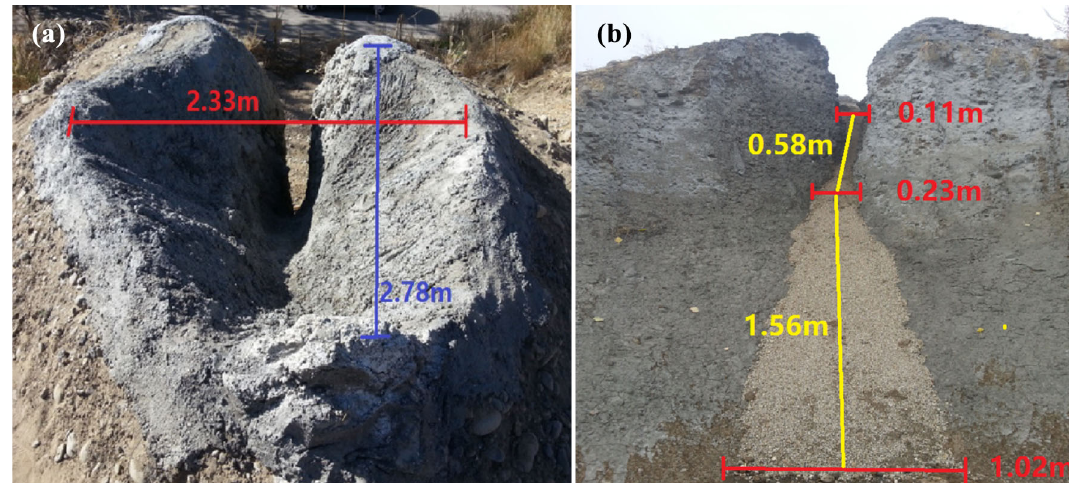
Fig. 4 Source region ( a ) and accumulation area of the sand debris flow model ( b )